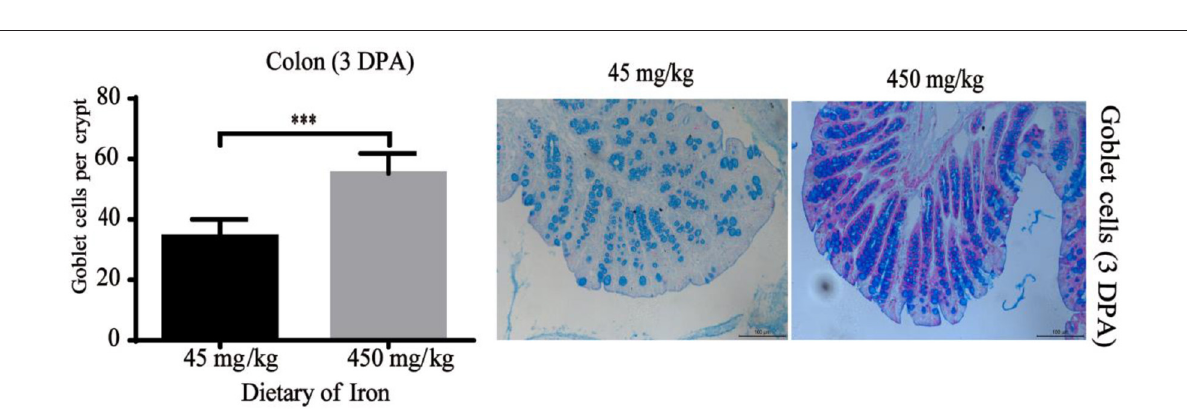
P = 0.046), and SOX9-positive cells in the jejunum crypts ( Figure 6D , P = 0.008) and colon ( Figure 6E , P < 0.001) were significantly